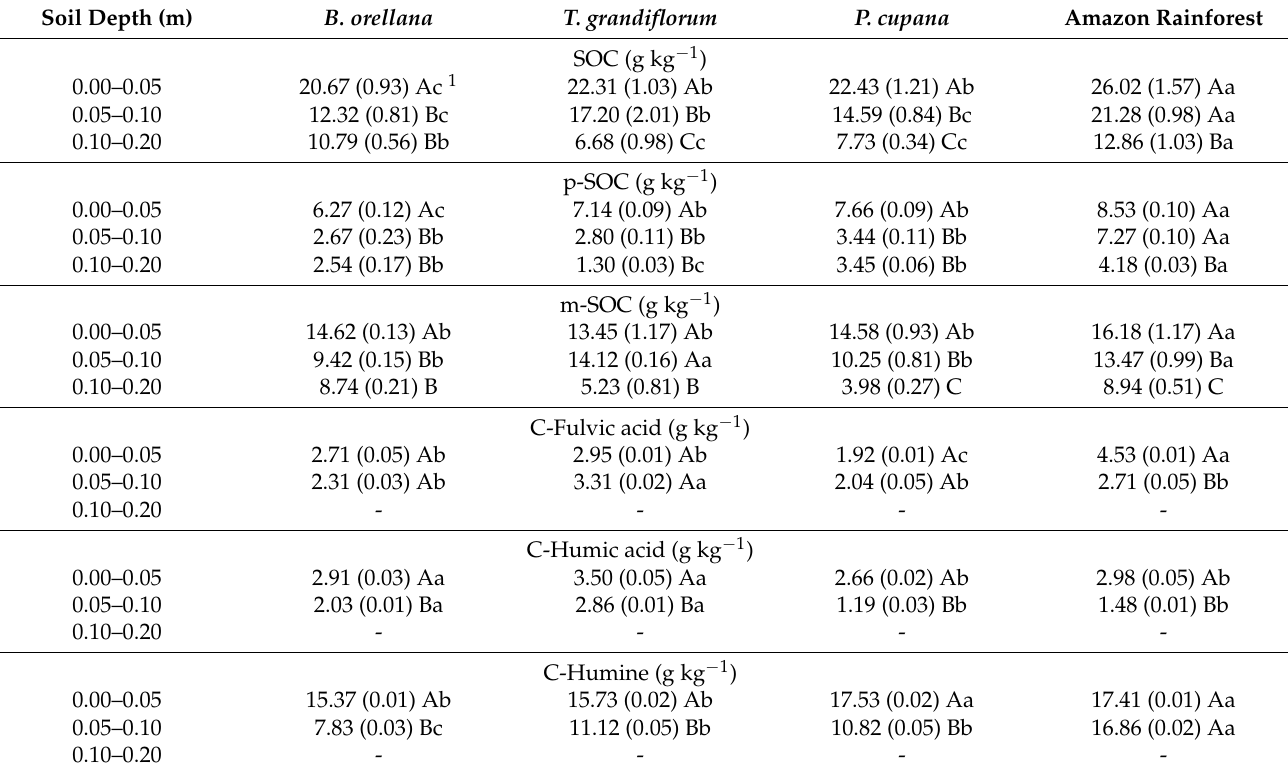
Table 2. Soil organic matter compartments among land use and soil depth in a Ultisols from Brazil’s Legal